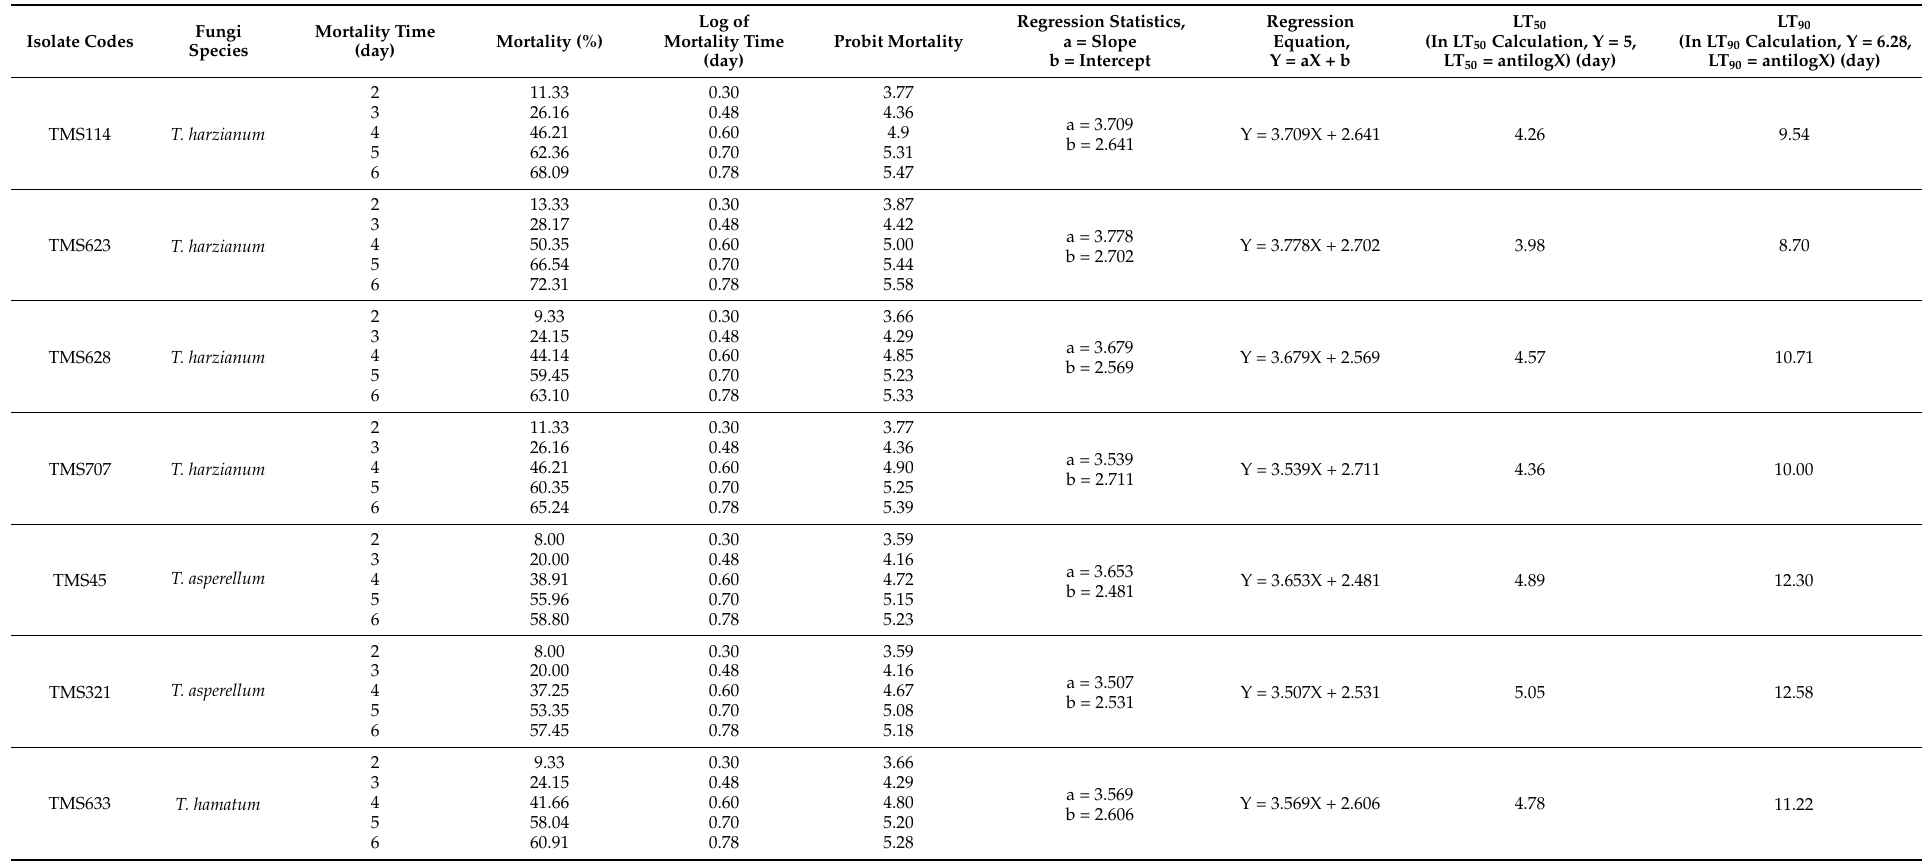
Table 5. LT 50 & LT 90 values for the efficacy of isolates against adults using mortality of different times (two to six days) at 1 × 10 8 conidia mL − 1